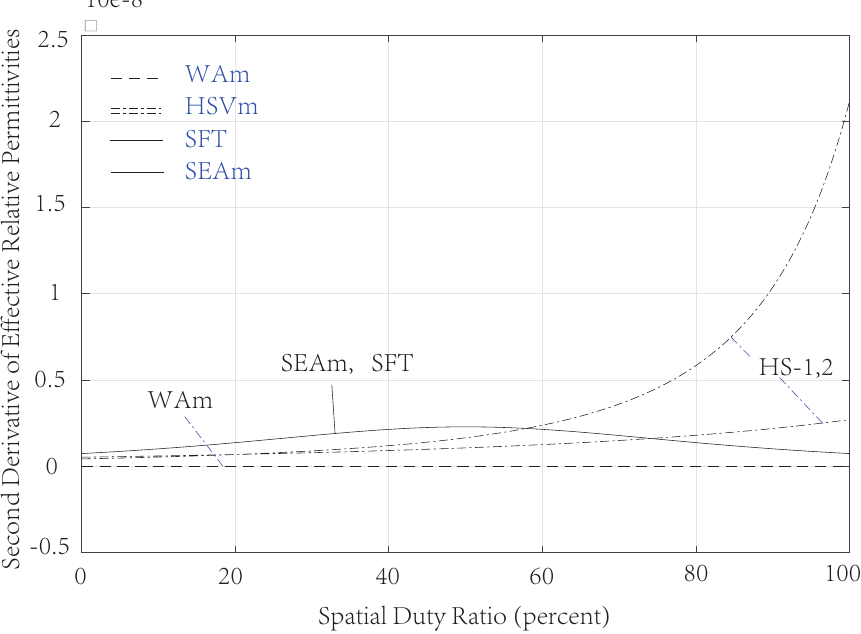
Figure 5. Absolute values of the second-order derivative functions of the effective relative permittivi- ties by WAm, SEAm, SFT, HS-1 (the upper boundary by HSm), and HS-2 (the lower boundary by HSm),